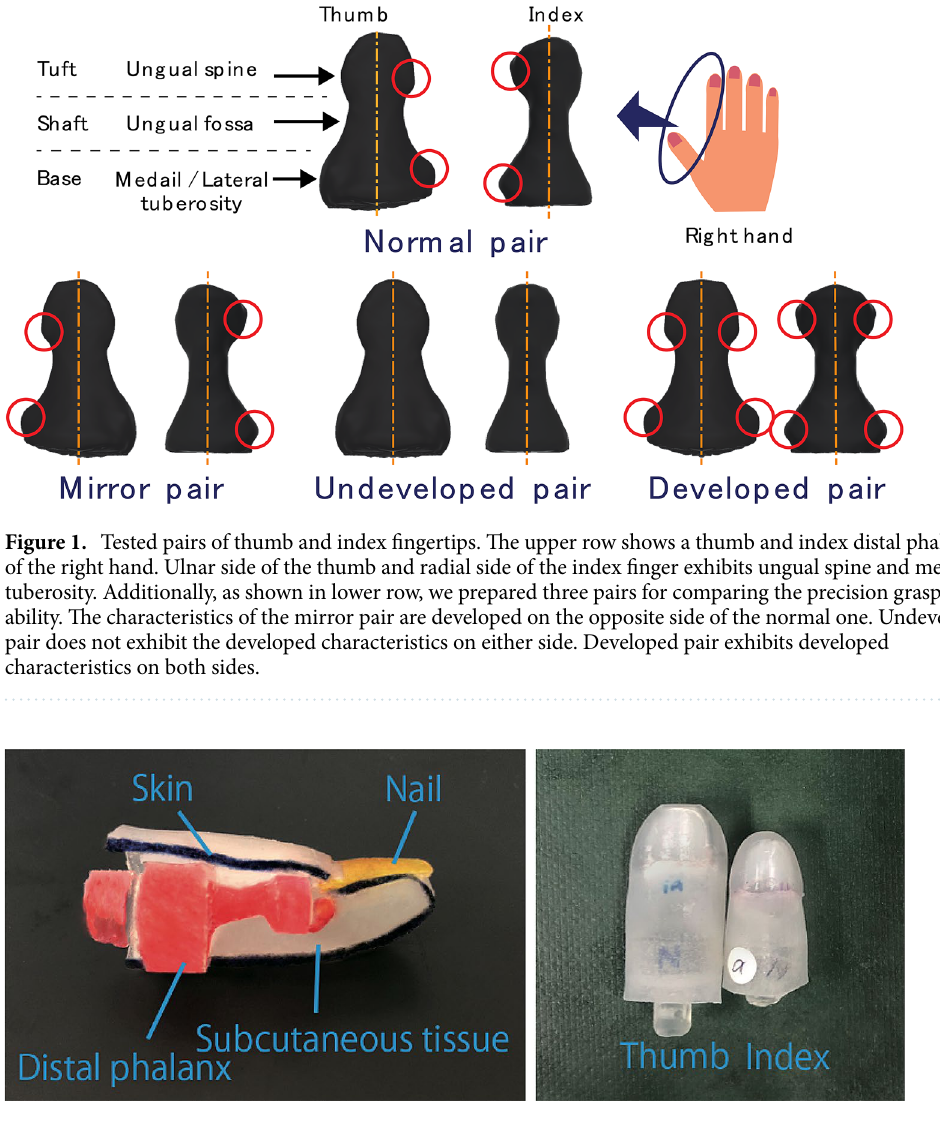
Figure 2. Developed artificial fingertips. Left figure shows the cross section of the developed artificial fingertip. The dummy nail is inserted in the back side of the dummy distal phalanx part. The hole is covered with dummy skin and the space is filled with dummy subcutaneous tissue. The right figure shows artificial thumb and index fingertips viewed from above. The size is approximately the same as that of an adult